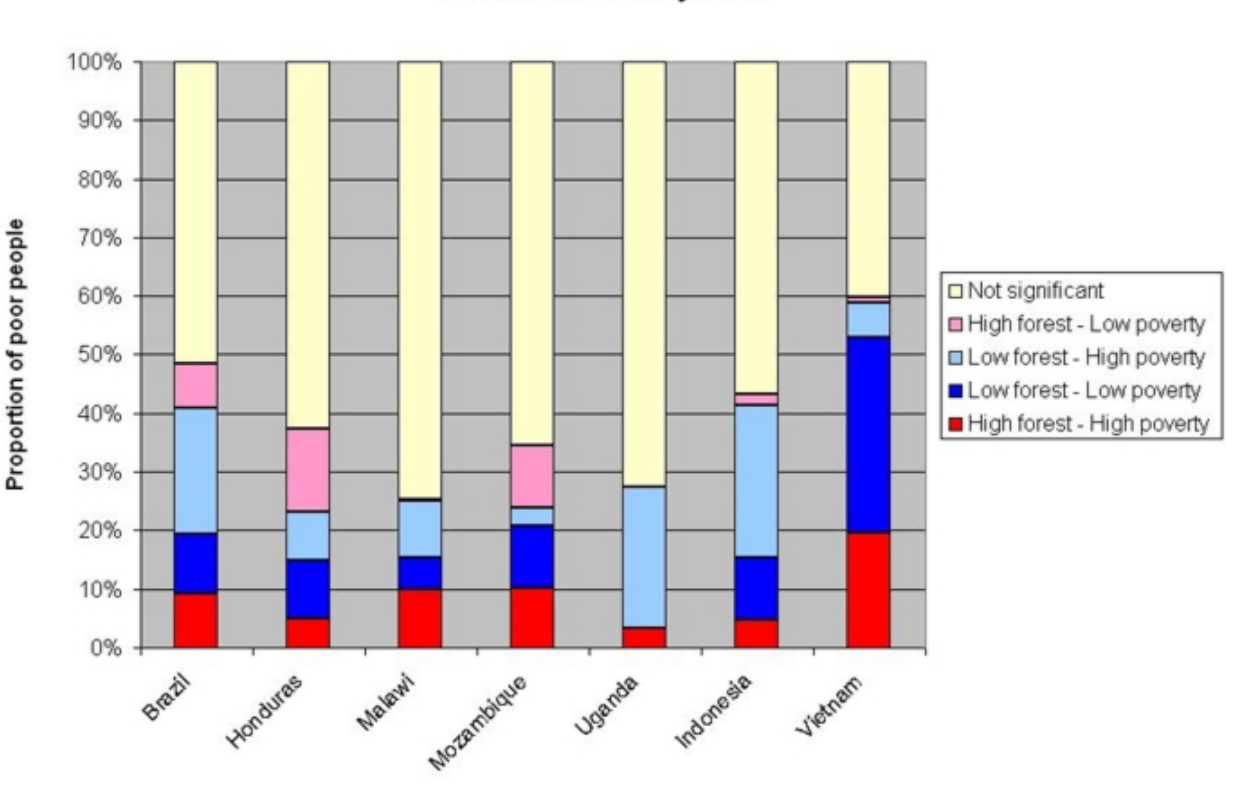
Fig. 9. Distribution of local indicators of spatial association forest vs. poverty rate findings by percentage of poor